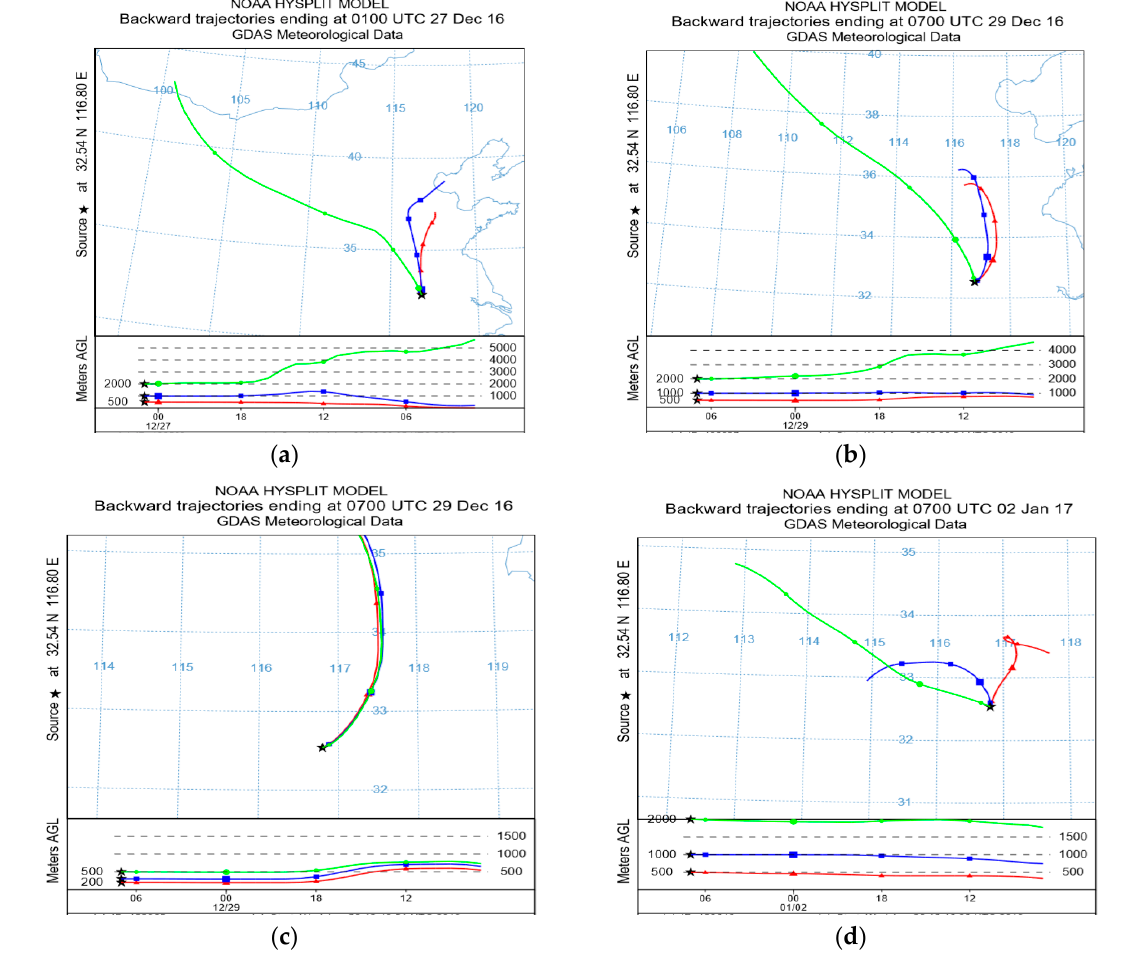
Figure 7. 24-h backward trajectories: ( a ) 9:00 on 27 December (local time); ( b ) 15:00 on 29 December (local time); ( c ) 15:00 on 29 December (local time); ( d ) 15:00 on 2 January (local time).